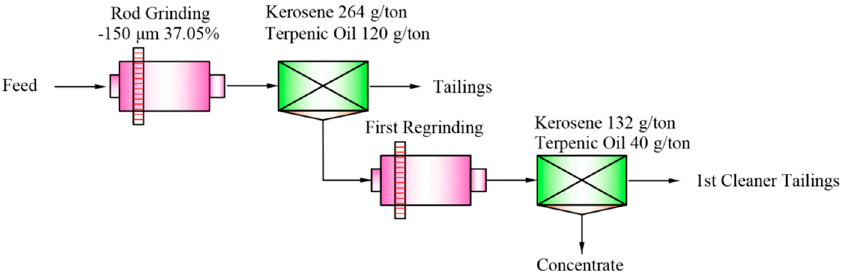
Figure 5. Flow chart of flotation for the first regrinding experimental parameters.